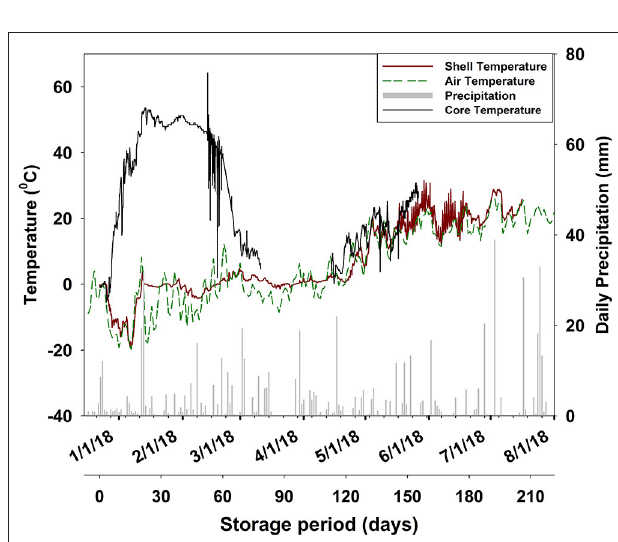
FIGURE 3 | Daily mean air temperature, precipitation, and temperature in the shell and core of a winter willow chips storage pile in Tully,